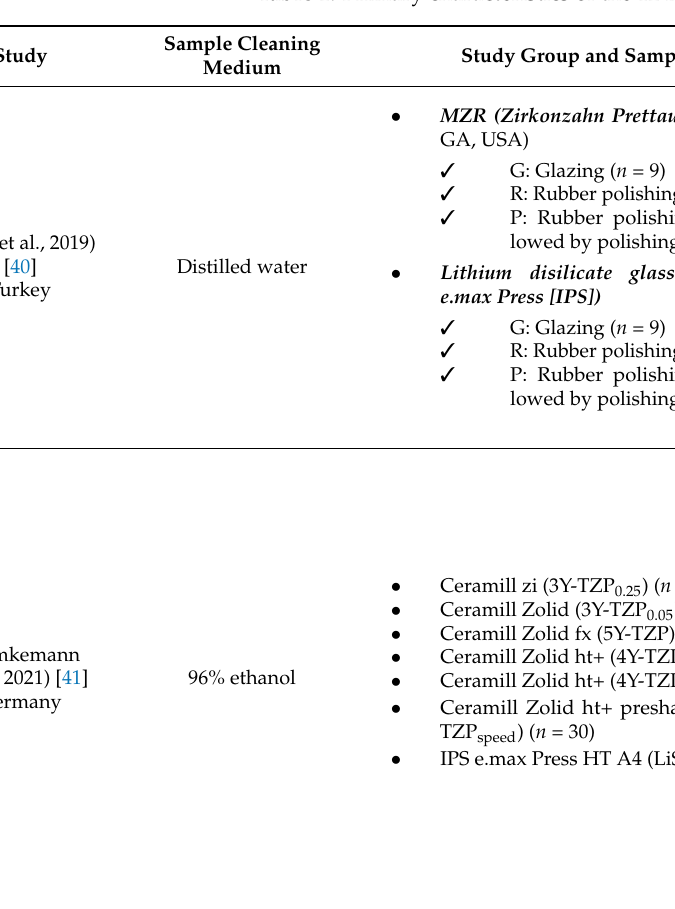
Table 1. Primary characteristics of the 12 included